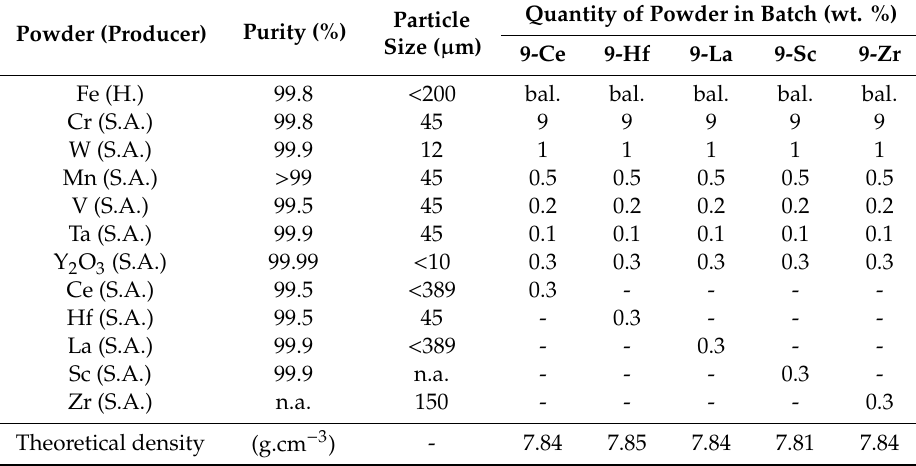
Table 1. Characteristics of the powders used for the steel preparation.